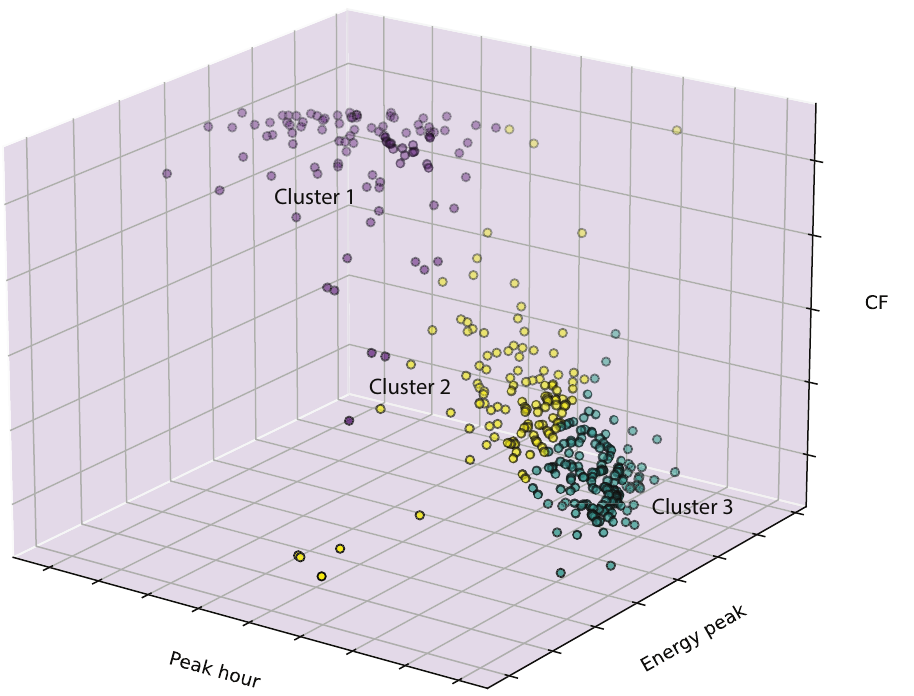
Figure 11. Peak hour VS Energy peak VS CF.